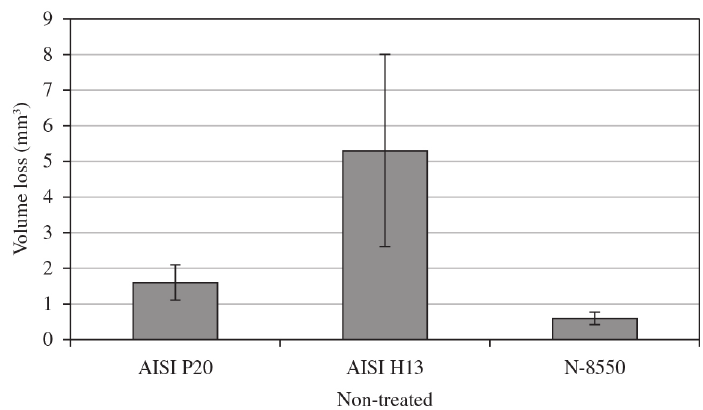
Figure 7. Wear volume results of non-treated AISI H13, AISI P20 and N-8550.